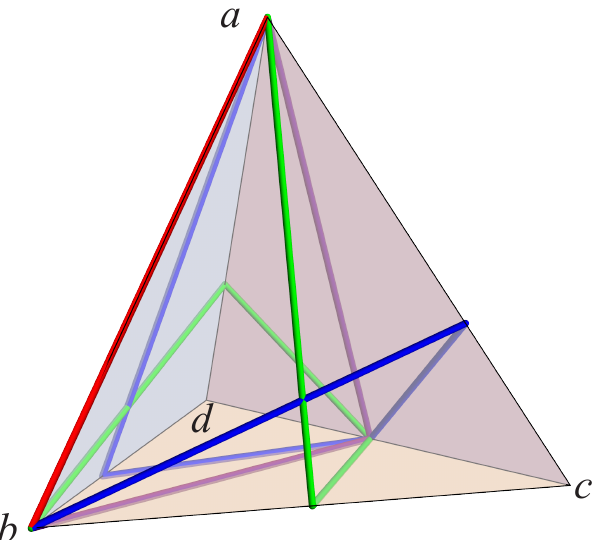
Figure 17. Three non-degenerate and one degenerate (red) Q 2 on a regular tetrahedron. The blue, green, and purple geodesic segments each connect to ab